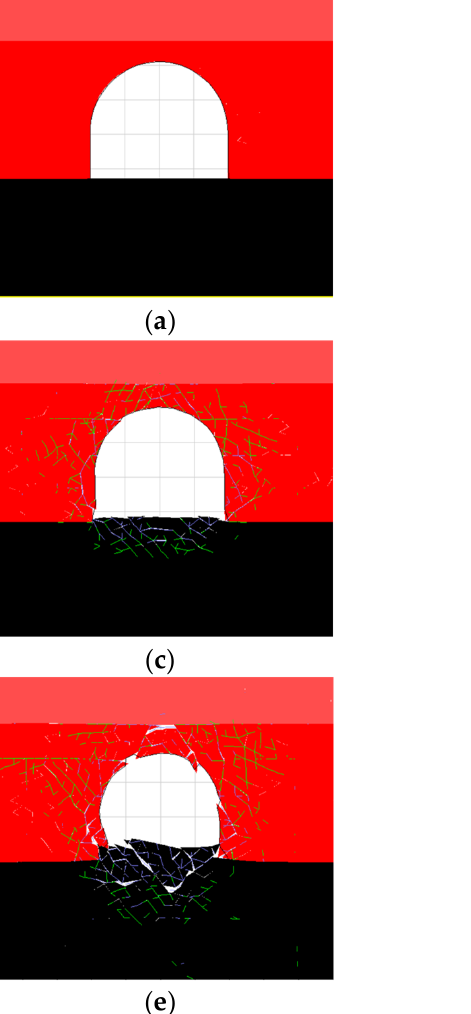
( b ) Figure 13. Comparison between on-site damage characteristics and simulated damage characteris- tics of the roadway. ( a ) simulated damage characteristics; ( b ) on-site damage characteristics.